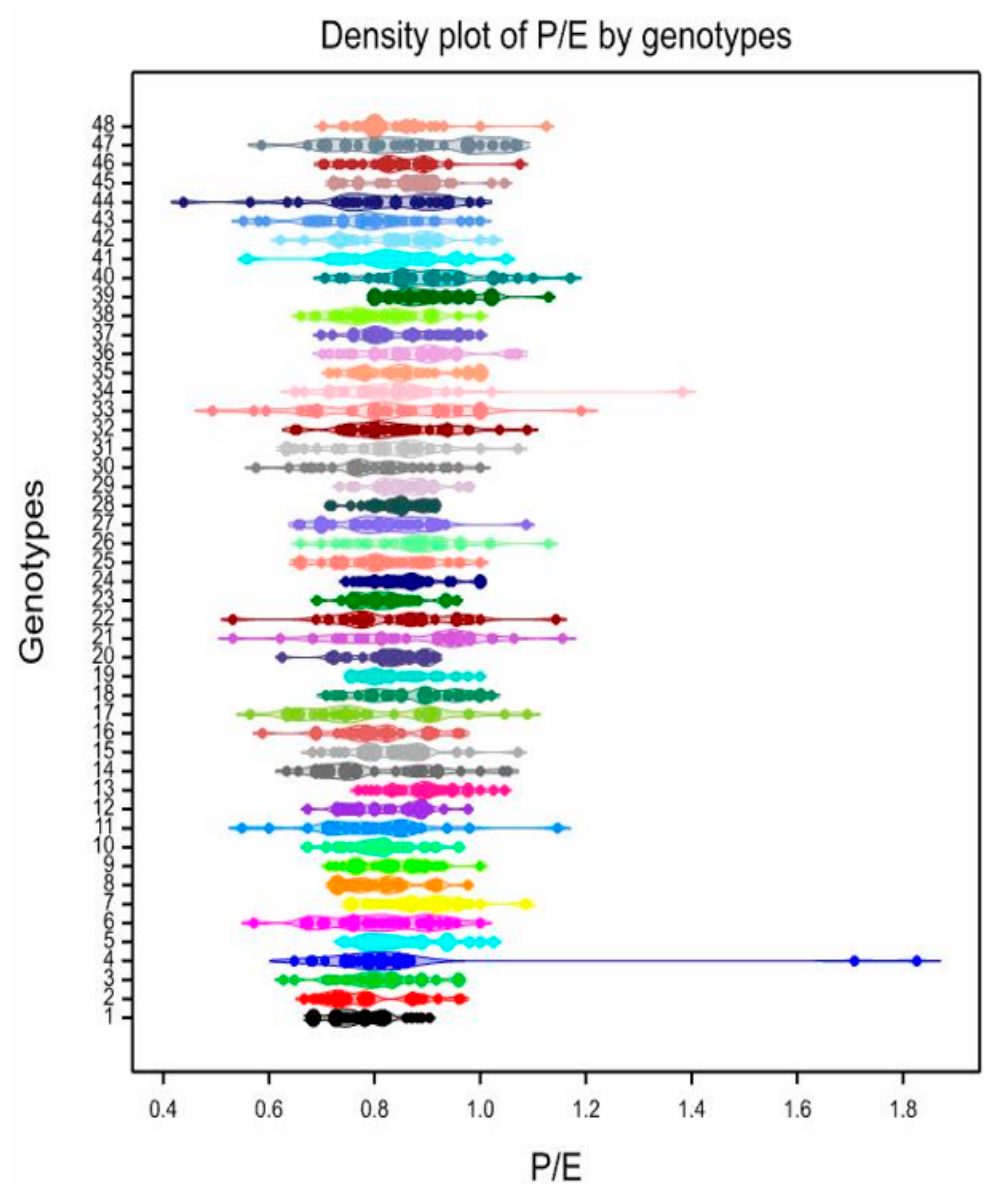
Figure 7. The density plot for the distribution of the shortest mean polar axis and the mean length of the equatorial diameter ratio (P/E), classified by Abies alba genotypes. Numbers from 1 to 48, see Table